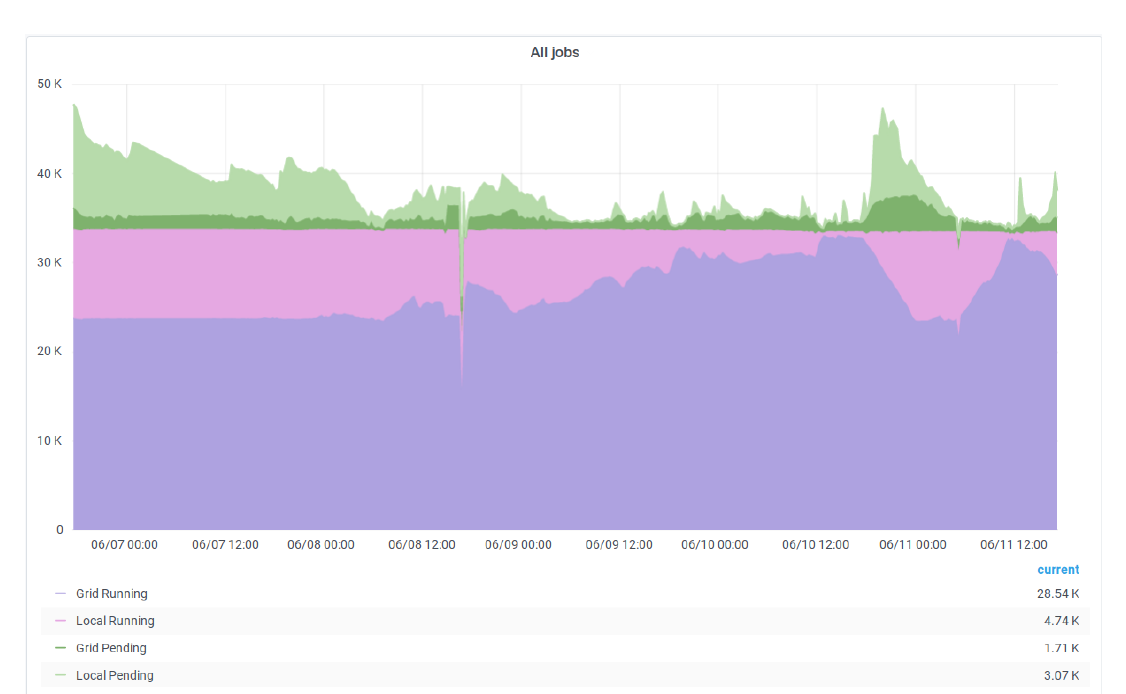
Figure 1. Migrating new Worker Nodes to